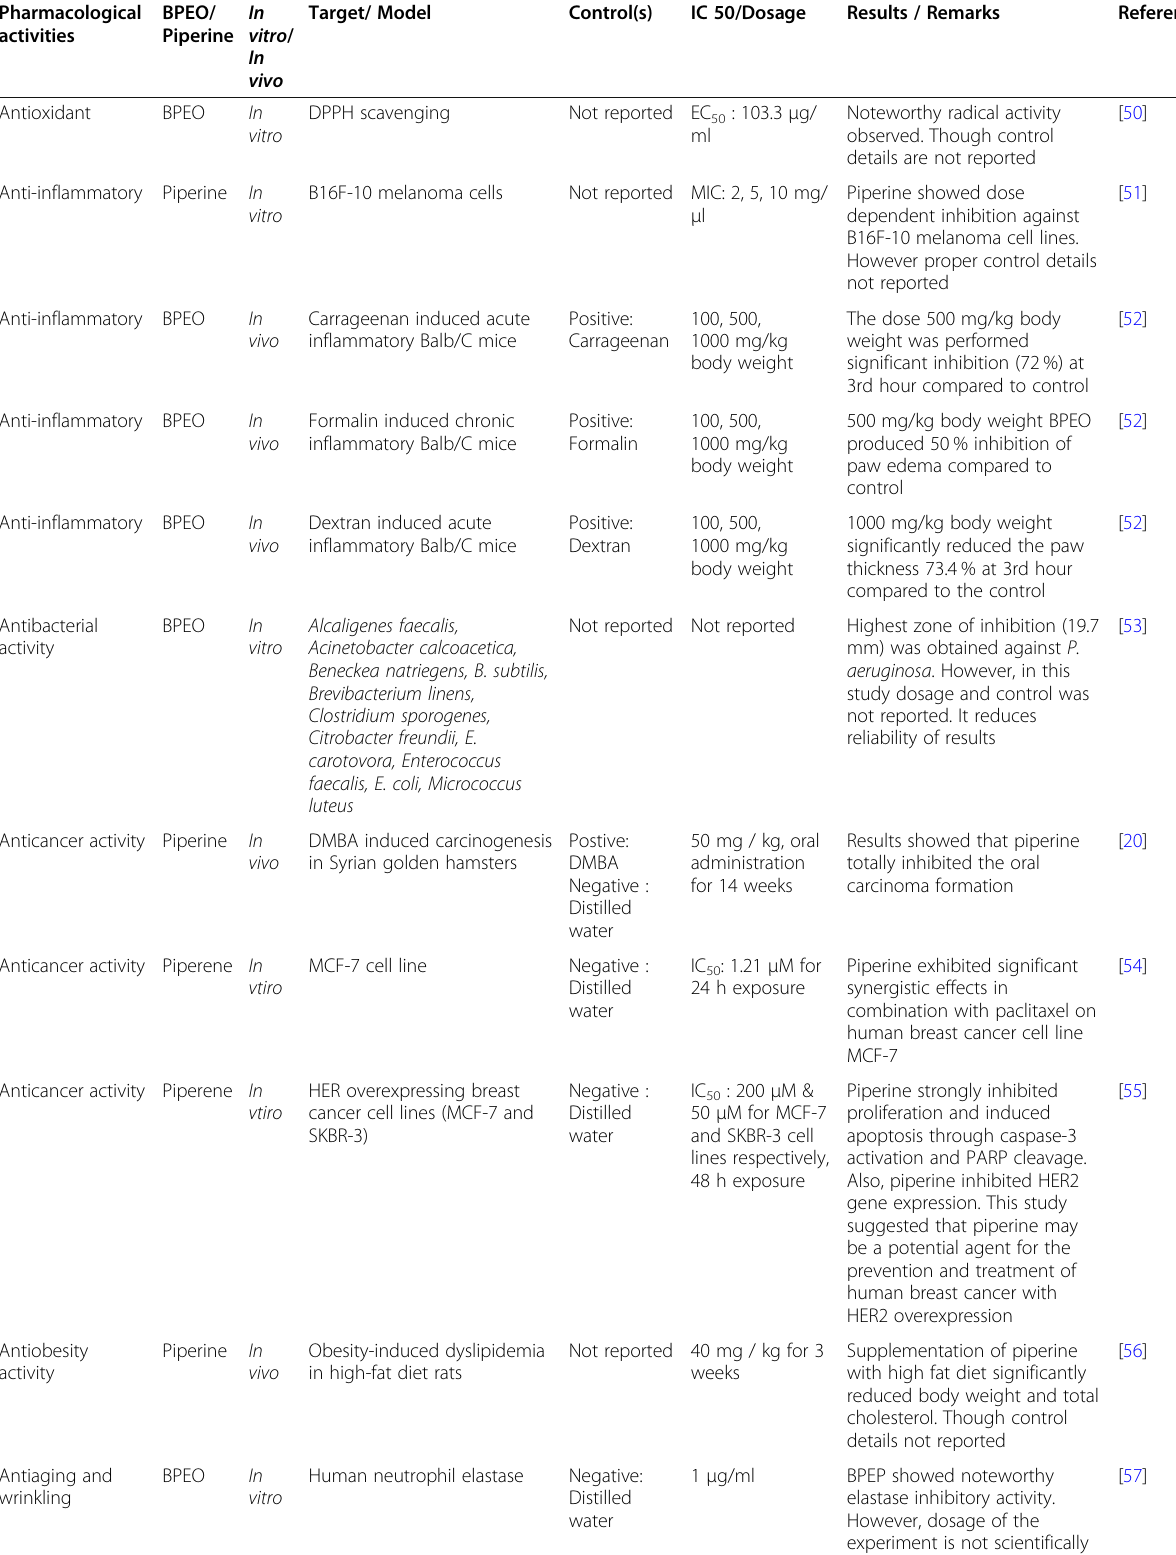
Table 4 Pharmacological activities of Piper nigrum extracts, piperine and BPEO Pharmacological